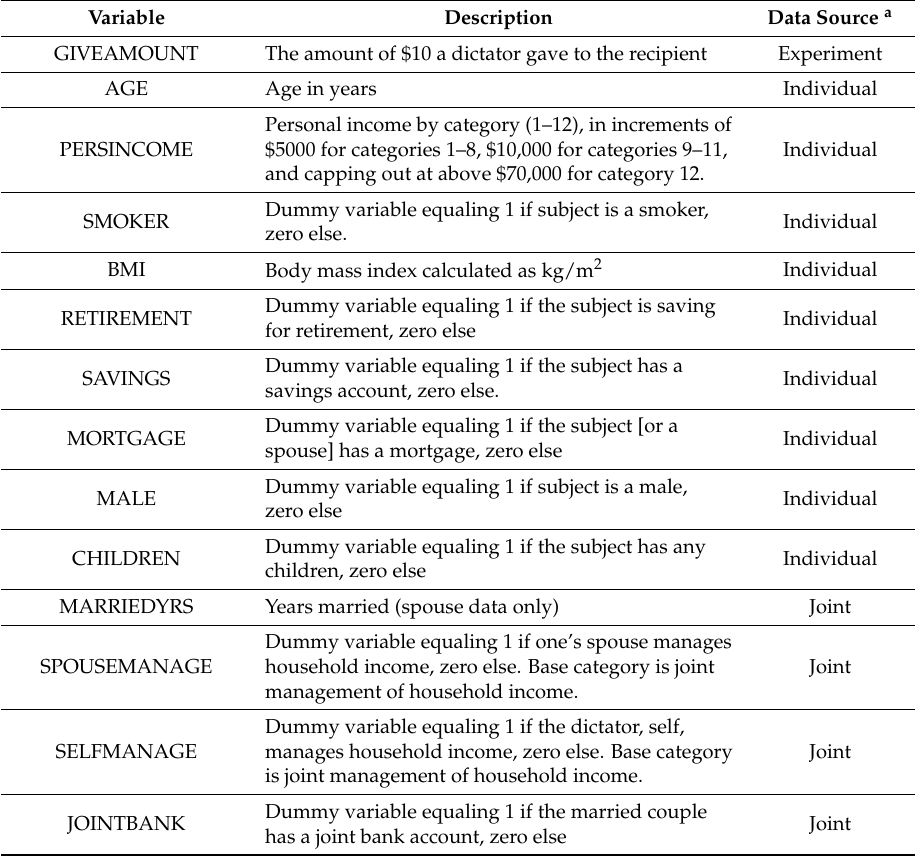
Table 1. Variable names and